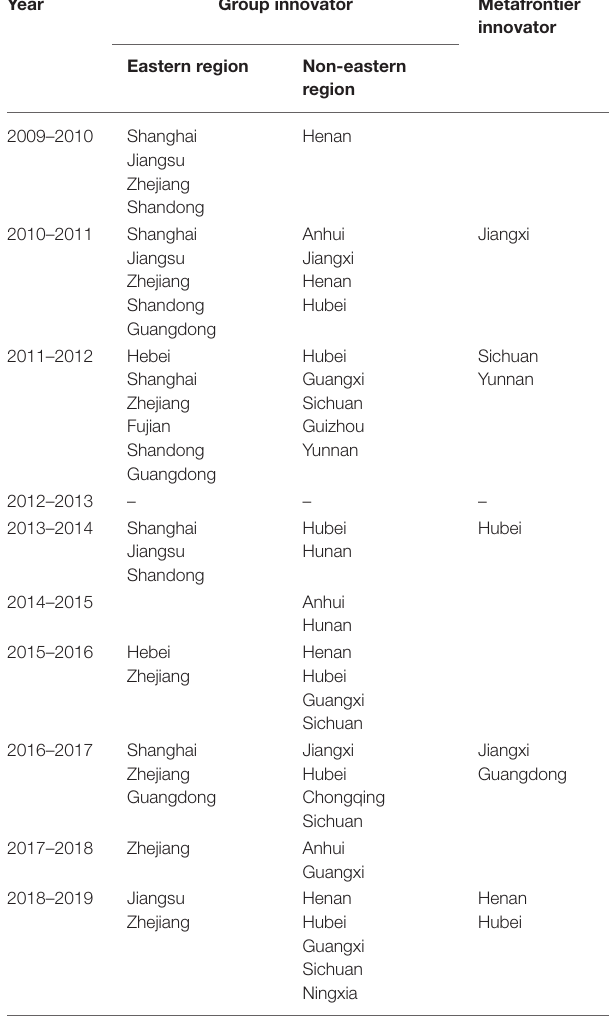
TABLE 3 | Group and metafrontier